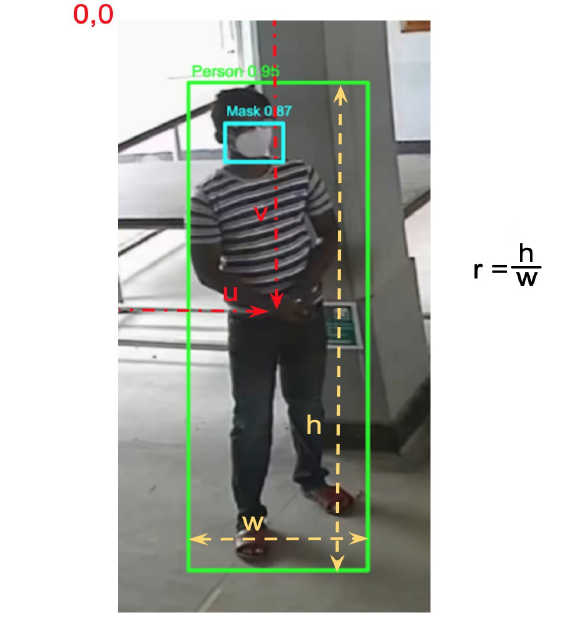
Figure 2. The parameters for the bounding